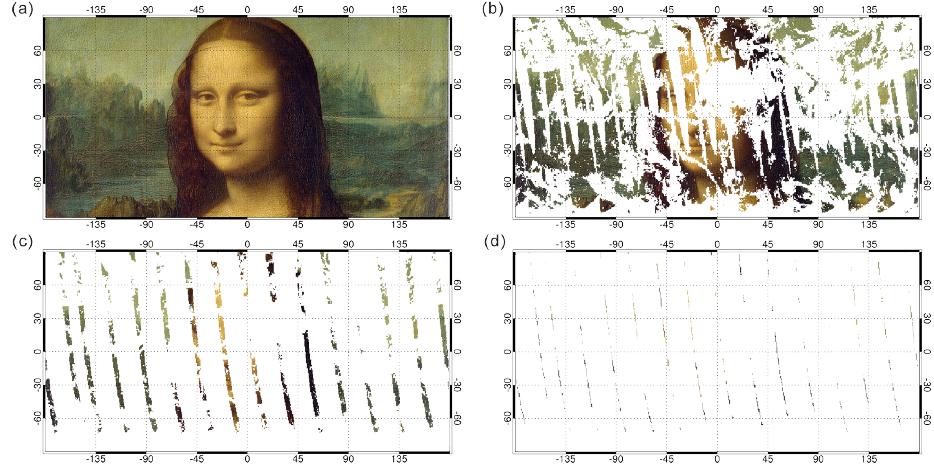
Figure 1. Conceptual illustration of the spatial sampling problem. Nature presents us with a “true” scene (a) . The truth is sampled according to “full-swath” sampling of the MODIS instrument on the Aqua spacecraft (b) , a “narrow” sampling (c) , and a single pixel wide “curtain” sampling (d) . For purposes of this illustration we are recovering only parts of the “true” image that had valid aerosol retrievals on 5 June 2010 from the MODIS over-ocean and “dark target” land